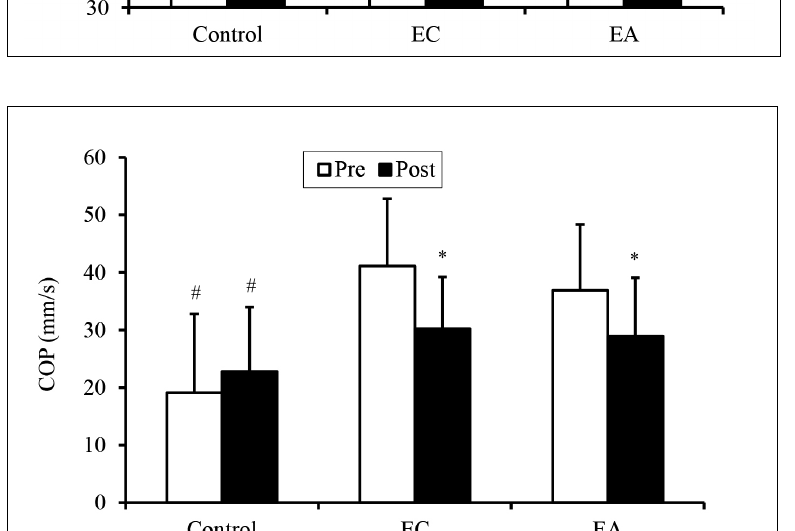
Note. * p < .05 comparing to pre intervention value.